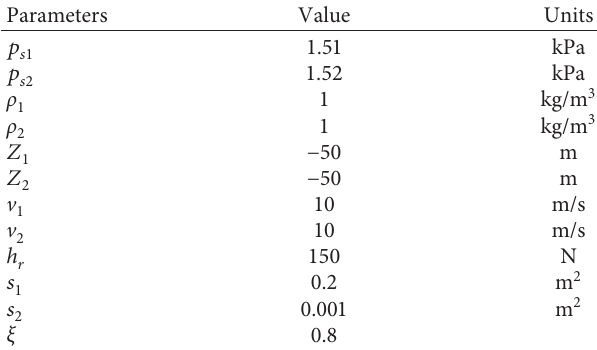
Table 1: The parameters of the ventilator.